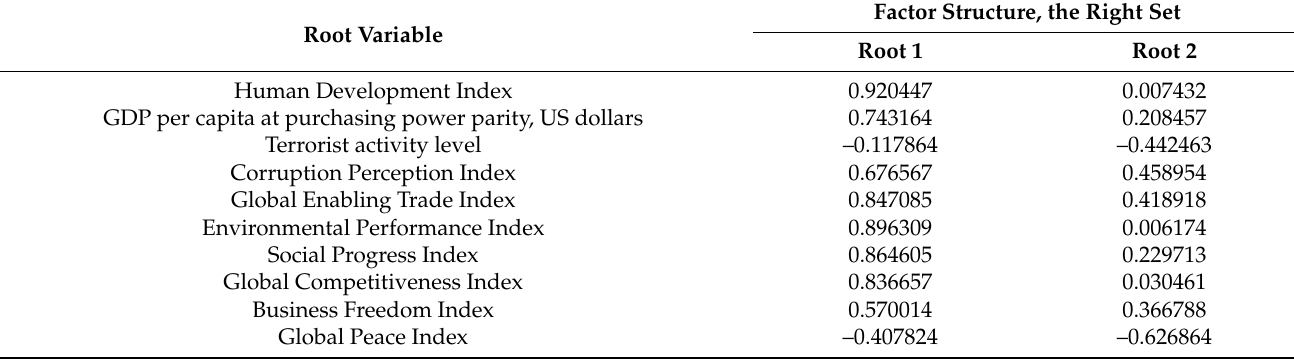
Table 3. Factor structure of the right set (set Y).